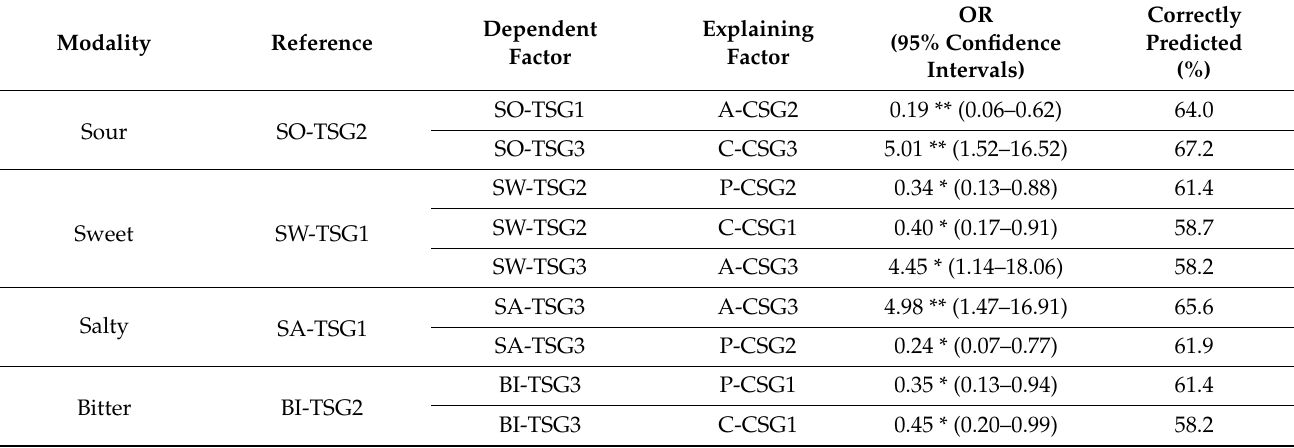
Table 6. The statistically significant odds ratios (OR) for taste modality-specific sensitivity groups explained by chemesthetic modalities by the multinomial logistic regression ( N = 189). The explaining chemesthetic modalities were analyzed separately to keep the reliability of the